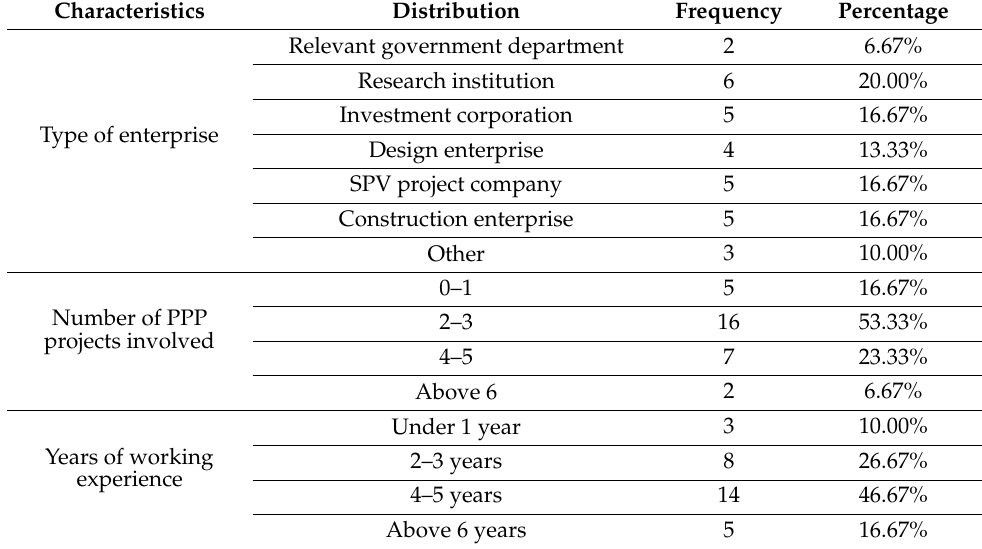
Table 2. Characteristics of the questionnaire